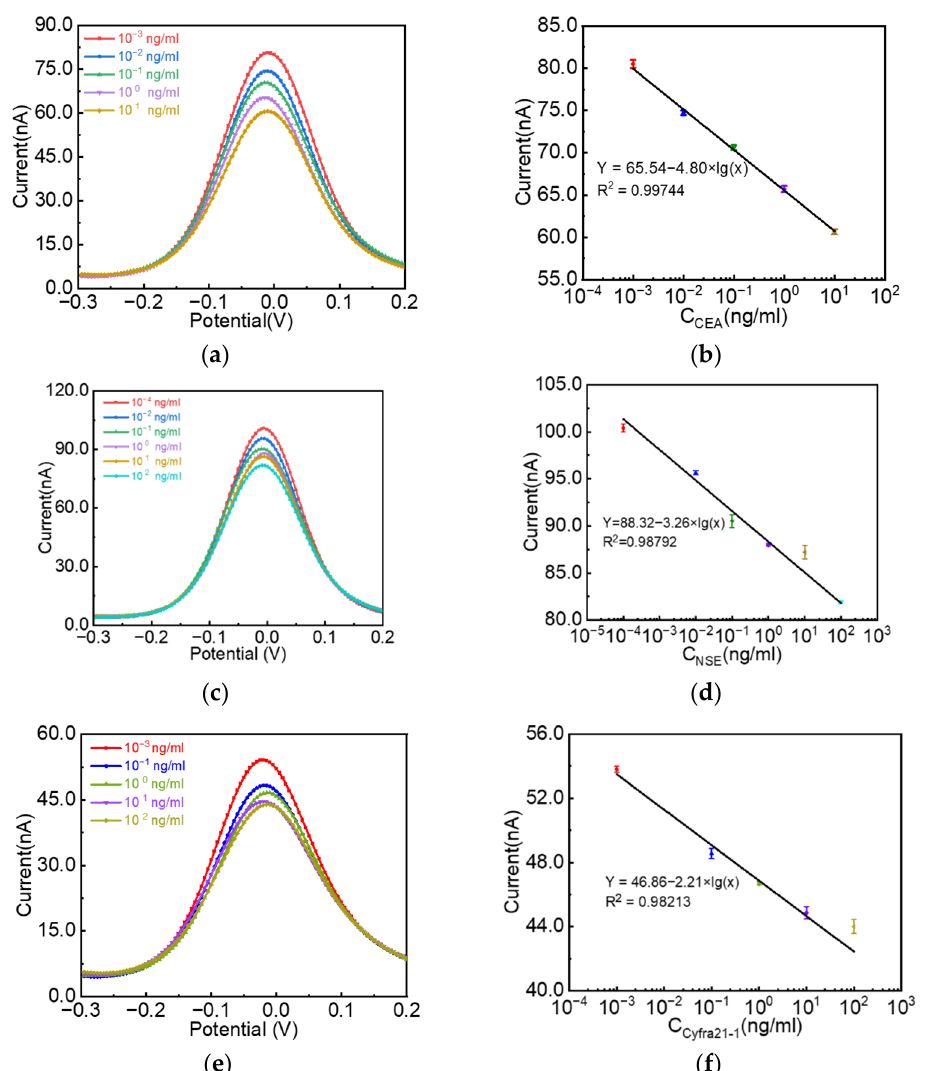
Figure 6. The signal responses of proposed immunosensor at different ( a ) CEA, ( c ) NSE, and ( e ) Cyfra21-1 concentrations. Linear relationship between the DPV peak current change and the logarithm of the concentrations of ( b ) CEA, ( d ) NSE, ( f ) Cyfra21-1.